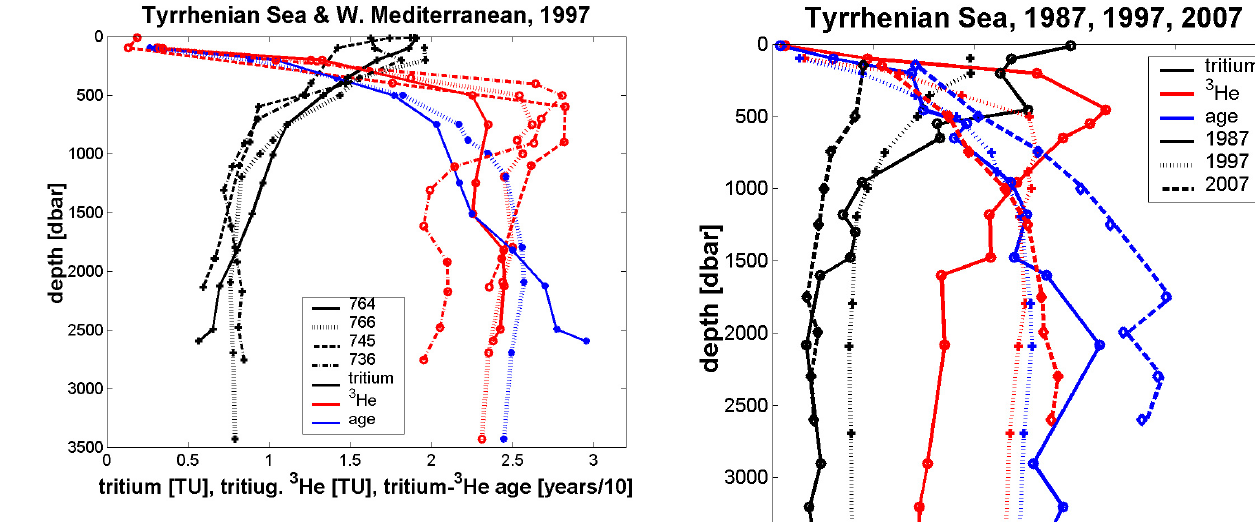
Fig. 4. Profiles of tritium and tritiugenic 3 He (both in TU) and of tritium- 3 He ages (Stas. 764 and 766 only) in the Tyrrhenian Sea and the WMed, P OSEIDON 234, 1997. Note that age scale is com- pressed 10-fold (1unit = 10years). For station positions see Fig. 1. Sta. 736 in the WMed replaces 738 shown in Fig. 3 which does not have tracer data, while T and S are nearly the same. Tritium data for station 766 converted from Sta. 765 data using a correlation with the tracer CFC-12 (Sect. 3).